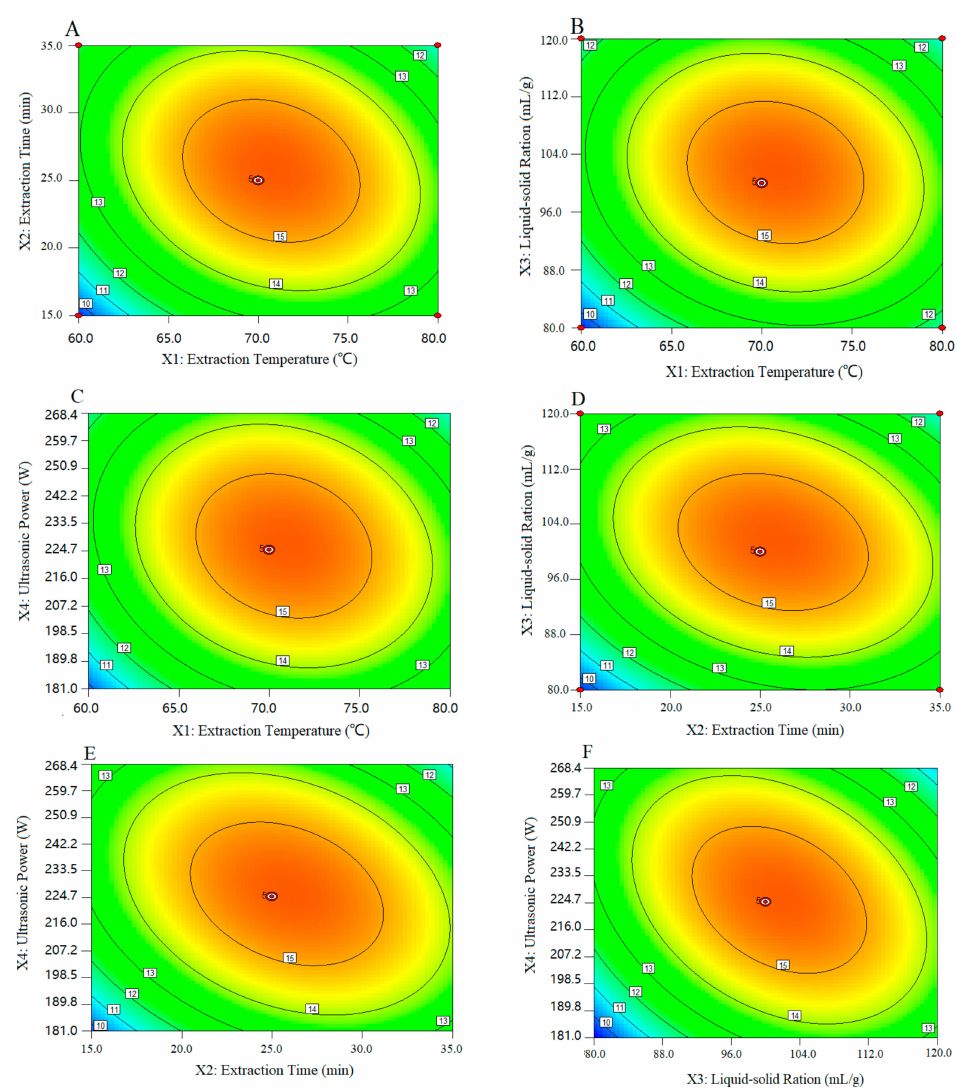
Figure 3. Contour plots showing the significant interactions of the extraction parameters. Extraction temperature and extraction time ( A ), extraction temperature and liquid-solid ratio ( B ), extraction temperature and ultrasonic power ( C ), extraction time and liquid-solid ratio ( D ), extraction time and ultrasonic power ( E ), and liquid-solid ratio and ultrasonic power ( F